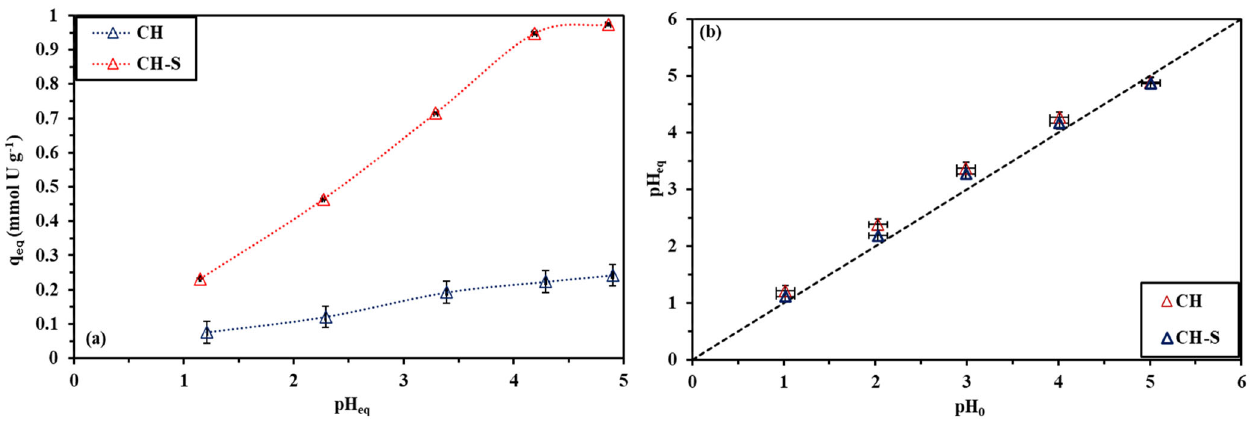
Figure 6. Effect of pH on uranyl sorption ( a ) and pH variation of the three experiments ( b